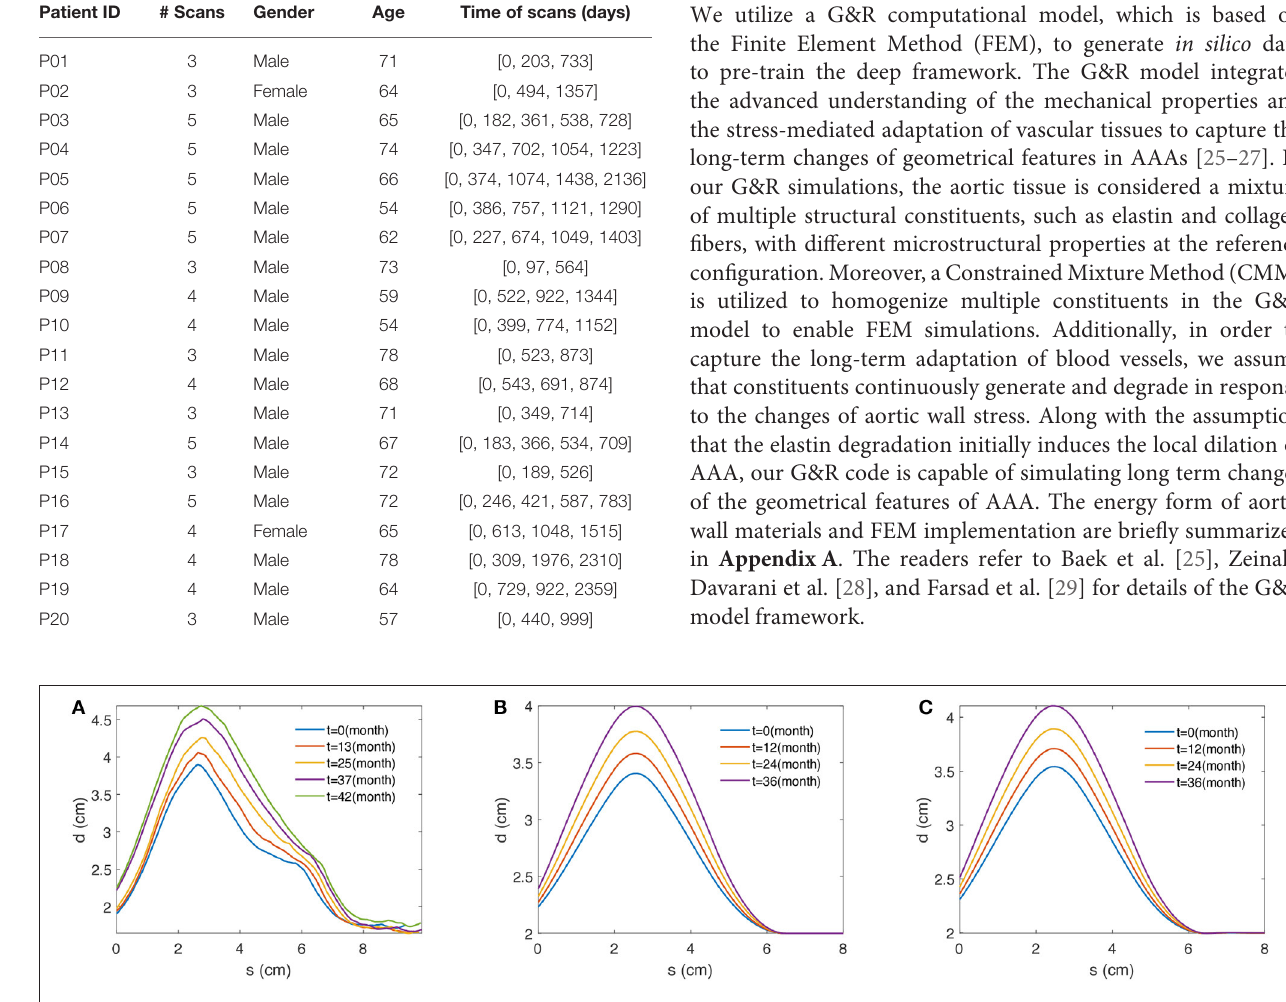
FIGURE 2 | Examples of 2D profile curves of maximal diameters over the centerline obtained from (A) a patient, (B) the G&R computational model, and (C) the PCM approximation. s (cm) defines the length along the centerline of AAA and d (cm) stands for the associated maximal diameter measured by the maximally inscribed sphere method